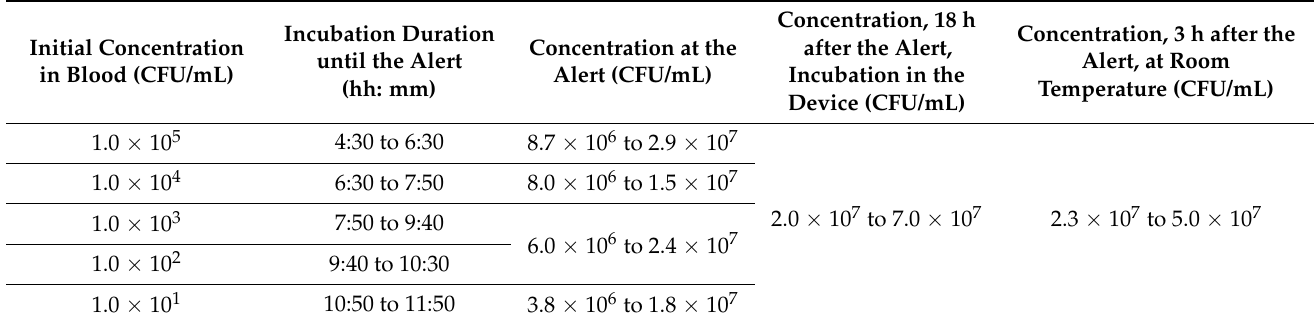
Table 4. Characterization of B. anthracis growth in blood culture